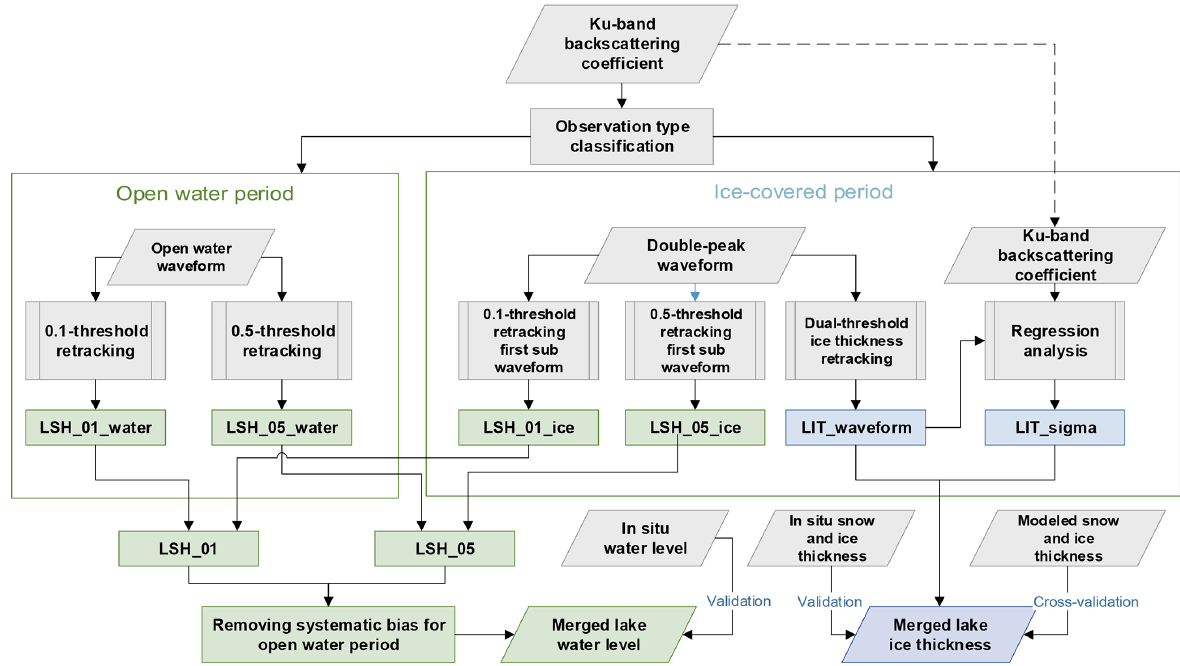
Figure 2. Workflow of this study. Procedures/intermediate data associated with LSH estimation are marked with green. Procedures/inter- mediate data associated with LIT estimation are marked with blue. LSH_01_water denotes that these intermediate data are the lake surface height (LSH) derived with a 0.1 threshold during the open-water period. LSH_01_ice denotes the same meaning but for the ice-covered period. LSH_01 denotes the time series containing all LSH retrievals derived with a 0.1 threshold. Similarly, LSH_05_water, LSH_05_ice, and LSH_05 denote the LSHs for different periods derived with a 0.5 threshold. LIT_waveform denotes the LIT derived from double-peak waveforms. LIT_sigma denotes LIT derived from backscattering